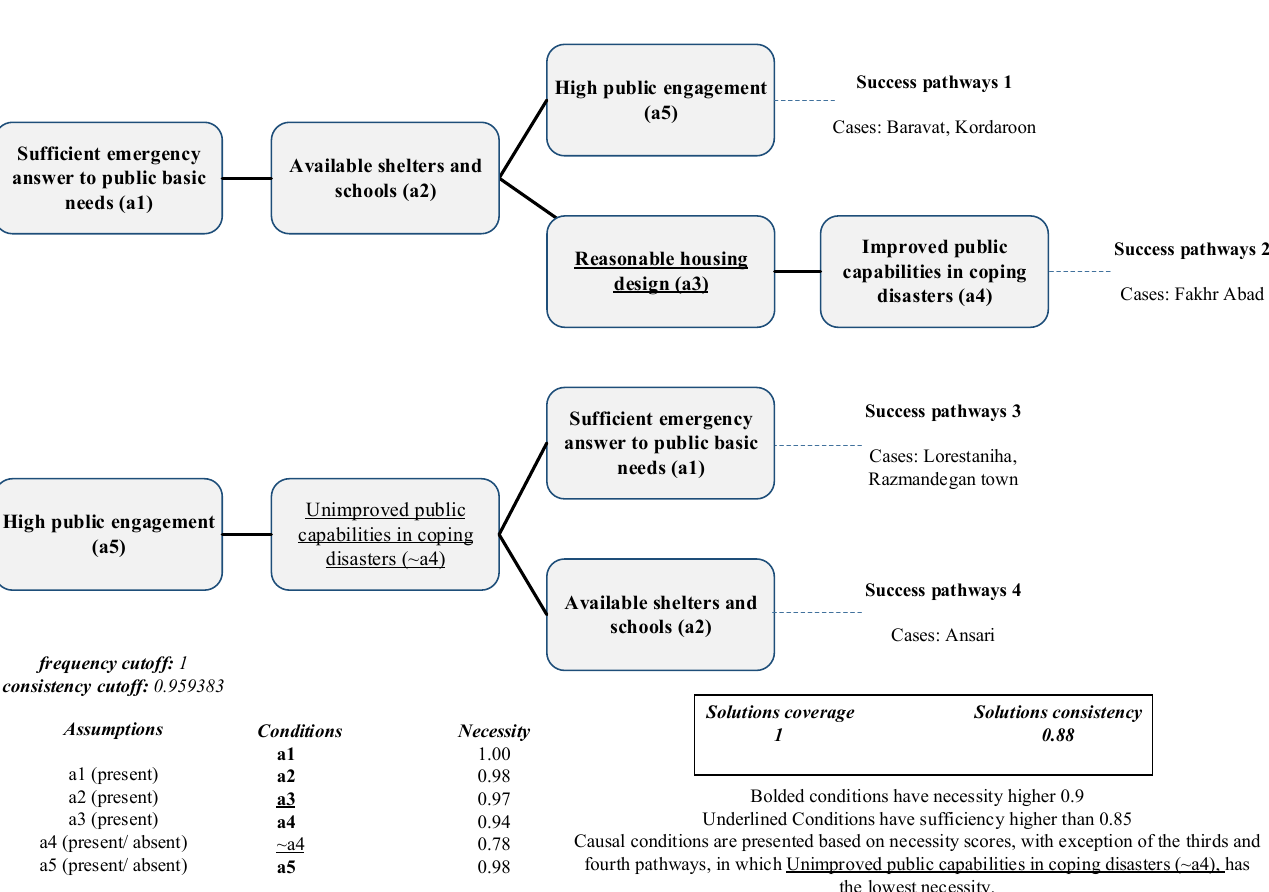
Figure 8. Pathways to the success of the ultimate outcome.